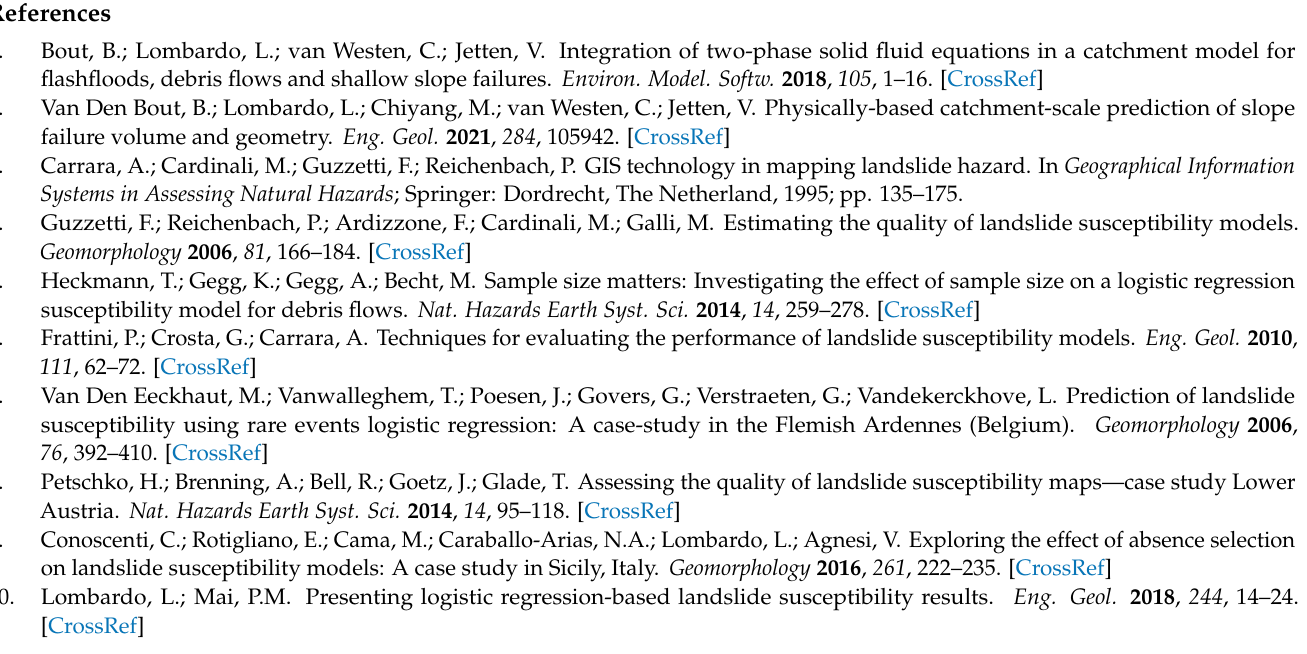
Figure A8. ROC curves from the 1st to 10th run at a varying proportion of landslide presence data. Each figure shows 10 ROC curves of cross-validation per 20 different landslide presence proportions (200 curves in each